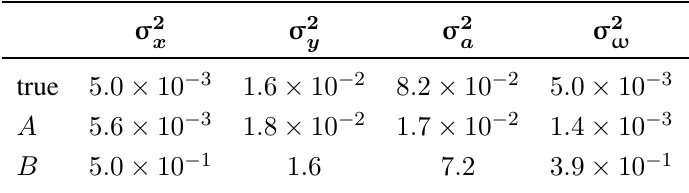
Table 2. True and estimated noise parameters of Dataset D 1 .